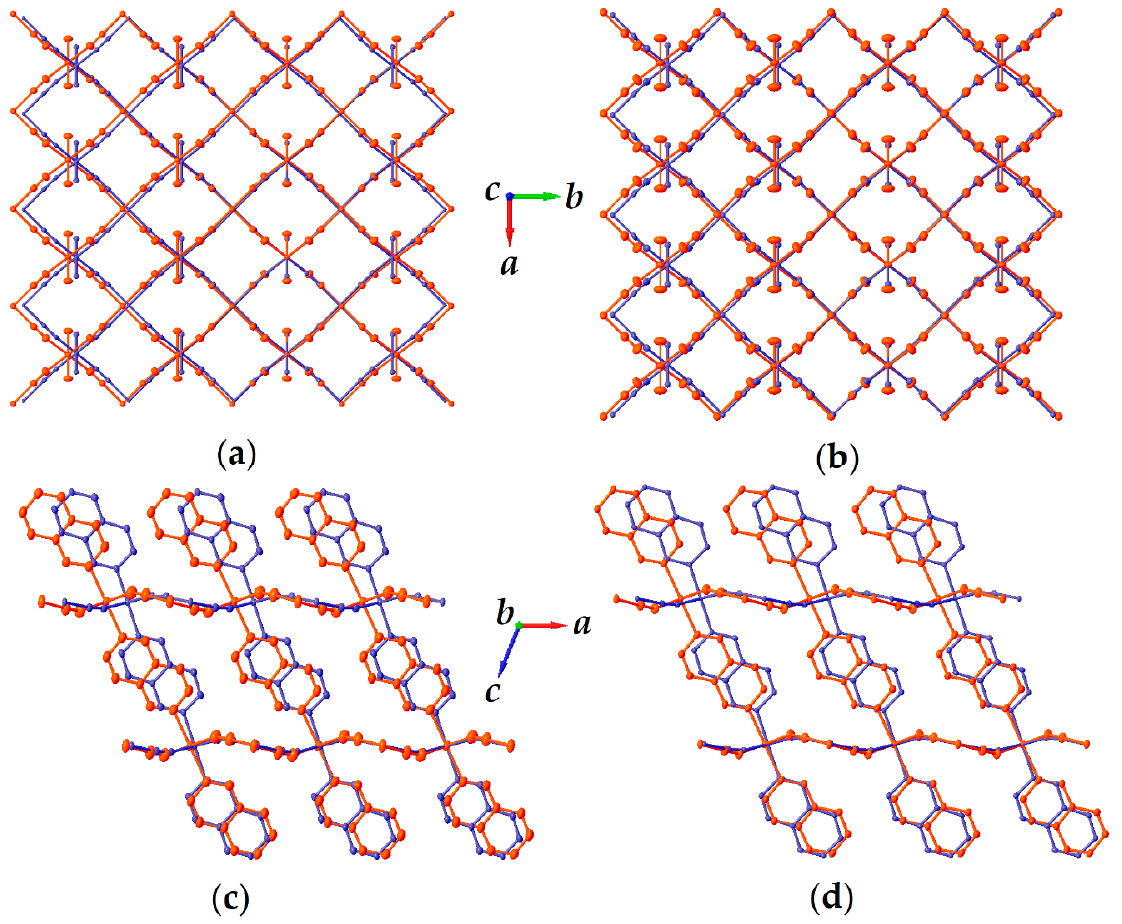
Figure 3. Superimposition of the LS (blue) and HS (red) sub-lattices of 1 ( a , c ) and 2 ( b , d ) along the c -axis and b -axis directions. Hydrogen atoms and disordered solvent are omitted for clarity.